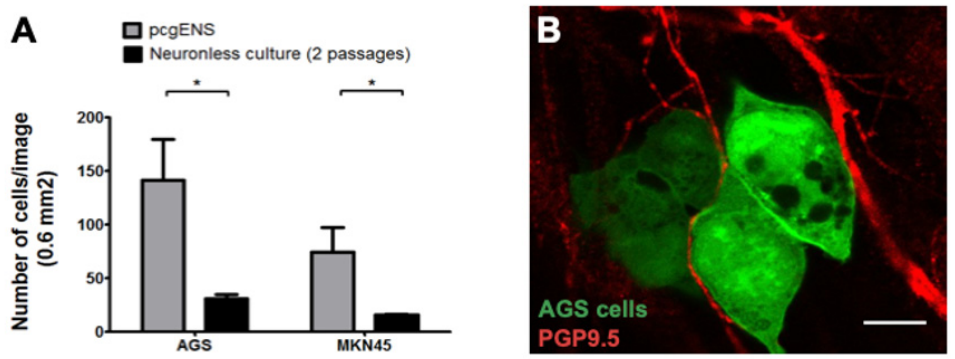
Figure 2. Importance of the enteric neurons in the adhesion of diffuse-type gastric cancer cells to the enteric nervous structures of pcgENS. ( A ) Comparison of cell number per image (0.6 mm 2 ) between pcgENS and cultures without neurons after 2 cell passages ( n = 19 wells for pcgENS and n = 10 for P2 cultures; * p < 0.05; Mann–Whitney test). ( B ) Confocal imaging of GFP-positive AGS cells adhered to enteric neurons (red/PGP9.5). Scale bar: 10 µm. ENS—enteric nervous system; pcgENS—primary culture of gastric ENS.